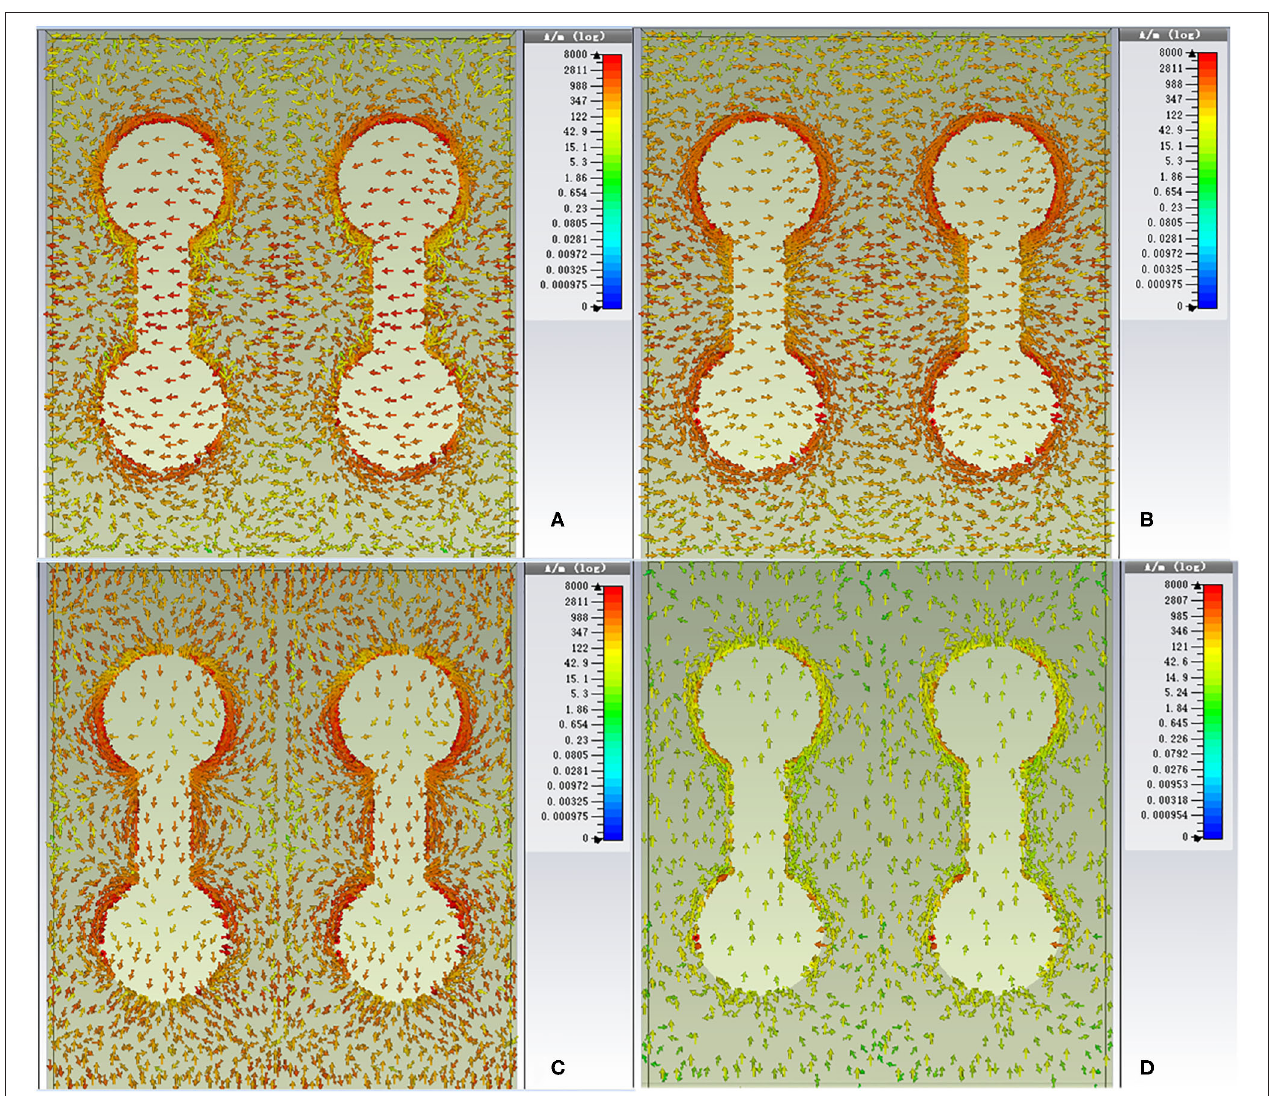
FIGURE 4 | Induced surface current distributions of the dumbbell-shaped graphene absorber for different modes: (A) TM for 0.5302 THz; (B) TM for 0.2242 THz; (C) TE for 0.5302 THz; (D) TE for 0.2242